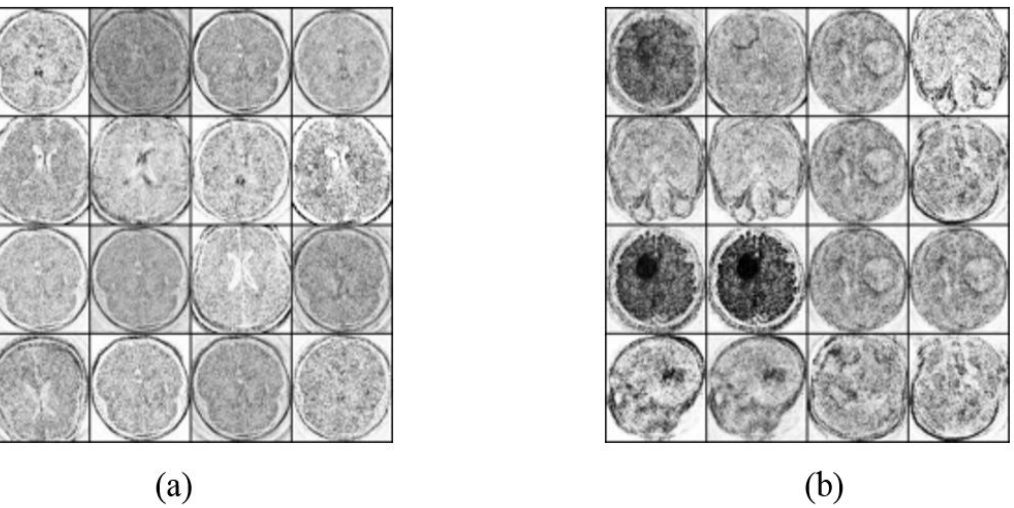
Figure 6. MRI scan images that are generated by applying Vanilla GANs for ( a ) Vanilla GANs no tumor images, and ( b ) Vanilla GANs tumor images.